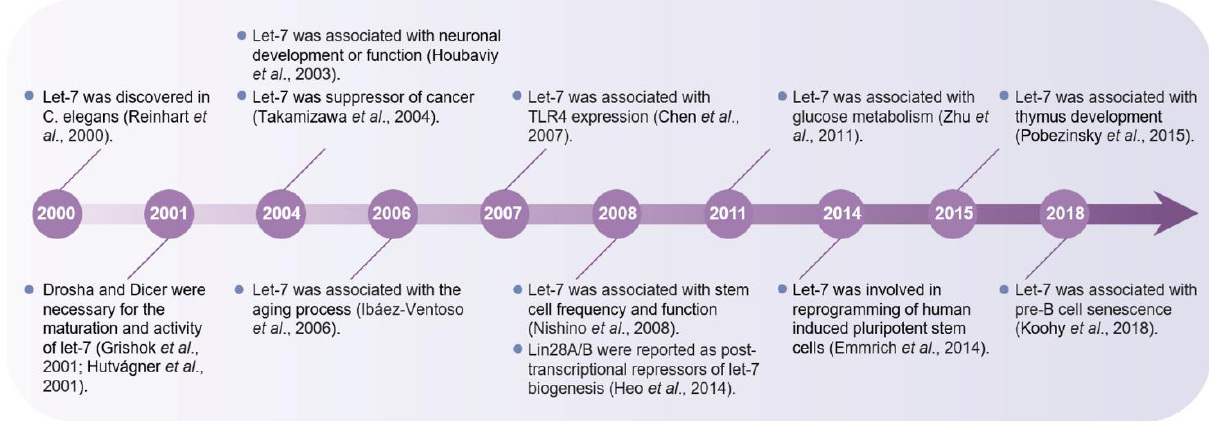
Figure 1. Timeline of major research discoveries related to